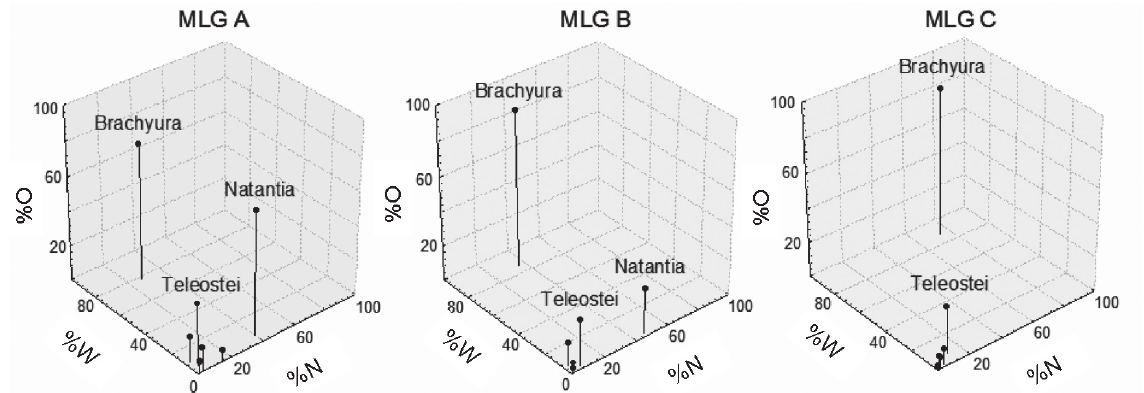
Fig. 4. – Three-dimensional representation of the feeding strategy of R. undulata by major length group (MLg): a) 200-550 mm; B) 550-750 mm; and C) 750-1000 mm.